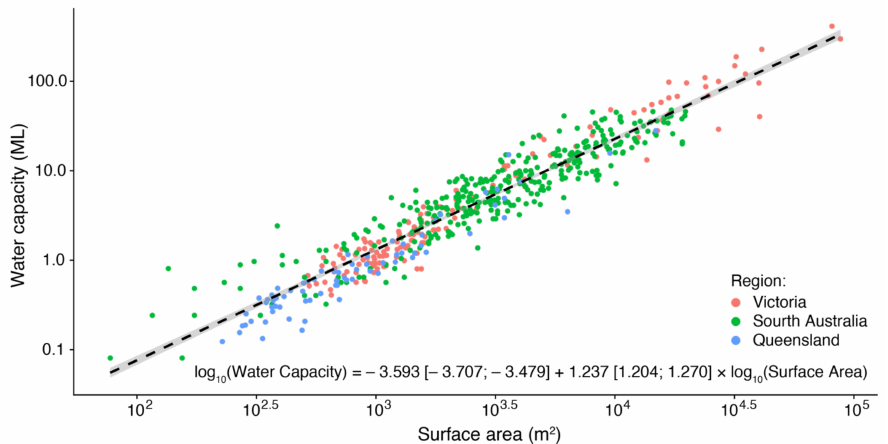
Figure 1. Calibration curve and model coefficients [ ± 95% confidence intervals] to estimate the water capacity of a farm dam from its surface area (R 2 = 0.91, F 1,556 = 5359.6, p < 0.001). We compiled data from three Australian studies (N = 558): farm dams in South Australia were sourced from McMurray (2004), those in Queensland from Sinclair Knight Merz (2012) and those in Victoria from Lowe et al. (2005). Water capacity was calculated using GIS techniques and Light Detection And Ranging (LIDAR) data. Surface area was calculated from satellite images. The range of surface areas covered in this relationship (from 10 2 to 10 5 ) is representative of the full range found among Australian farm dams (cf. Figure 3). The bootstrapping methods to estimate the statistics on total water capacity in Australian farm dams (Figure 5C) included the uncertainty in this relationship.